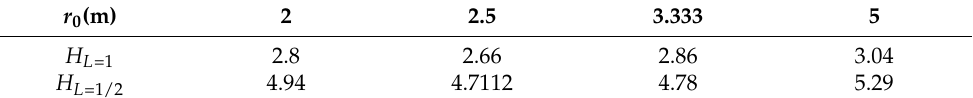
Table 5. Entropy analysis for 4 ANs with different transmission ranges, r 0 , and discretization unit L .